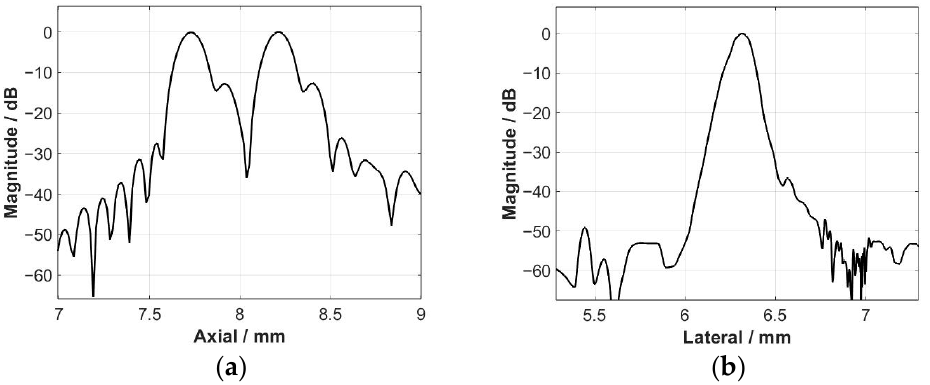
Figure 12. ( a ) The captured axial beam pro fi les and ( b ) lateral beam pro fi les.